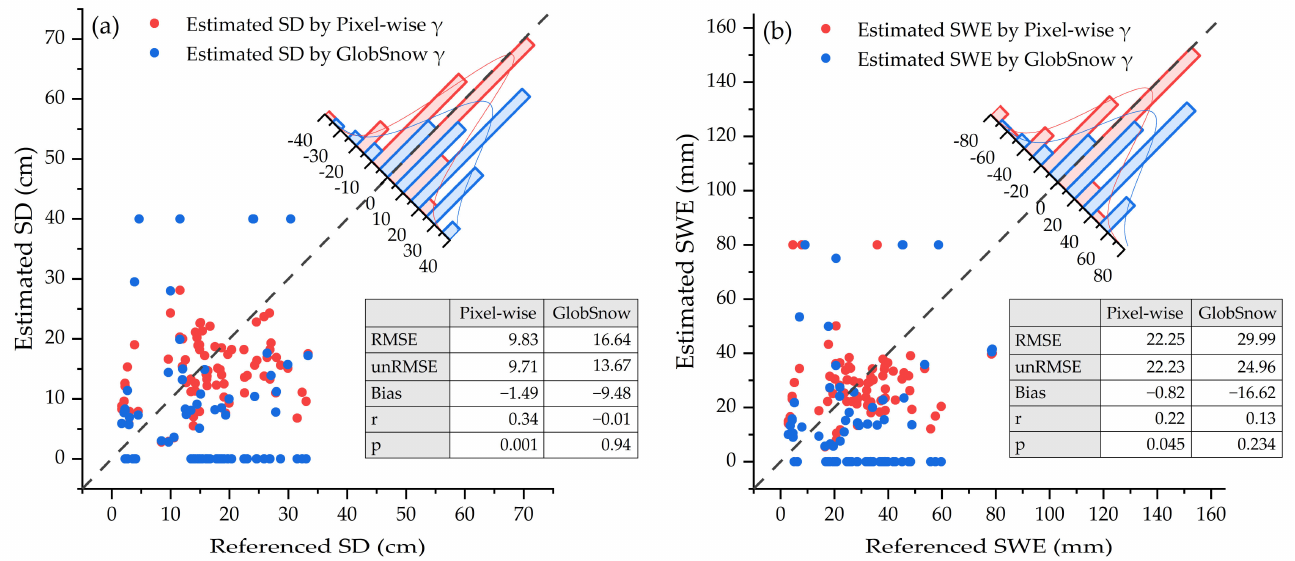
Figure 3. Corner difference (referenced value minus estimated value) histogram of ( a ) SD and ( b ) SWE inversion